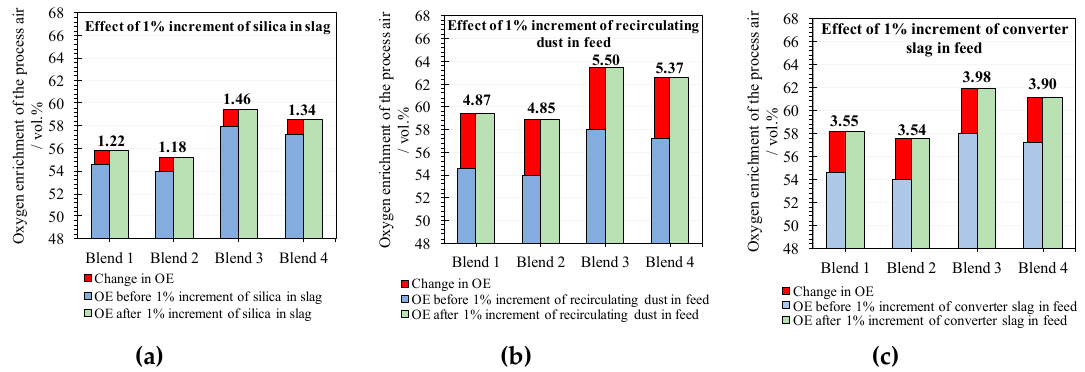
Figure 5. Oxygen enrichment (OE) estimated for increments of some parameters: ( a ) Increment of 1% of silica in the slag composition, ( b ) increment of 1% of recycled dust in feed, and ( c ) increment of 1% of slag converter in the feed.